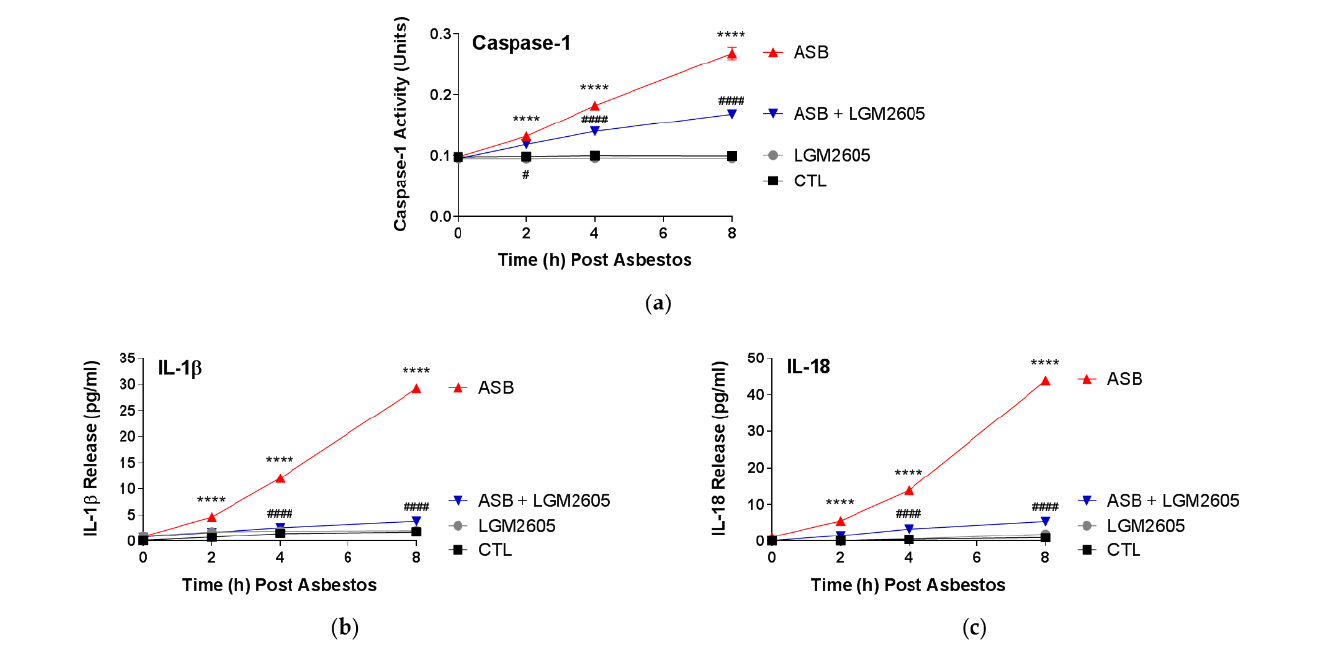
Figure 5. LGM2605 Reduces Asbestos-Induced Caspase-1 Activity and NLRP3 Inflammasome-Activated Cytokine Release in Human Pleural Mesothelial Cells. Human pleural mesothelial cells were plated in a 6-well plate (1 × 10 6 cells/well) and exposed to 50 µ M LGM2605 4 h prior to exposure to sterile crocidolite asbestos fibers (20 µ g/cm 2 ). NLRP3 inflammasome activation (cleavage and activation of procaspase-1) following asbestos exposure activates IL-1 β and IL-18 via activated caspase-1. Caspase-1 activity ( a ) was determined from cell nuclear extracts. The levels of IL-1 β ( b ) and IL-18 ( c ) were determined in the cell culture medium at 0, 2, 4, and 8 h post asbestos exposure. Data are presented as mean ± SEM. * indicates a statistically significant difference ( p < 0.05) between ASB and CTL treated cells (**** p < 0.0001). # indicates a statistically significant difference ( p < 0.05) between ASB and ASB + LGM2605 treated cells (# p < 0.05 and #### p < 0.0001).